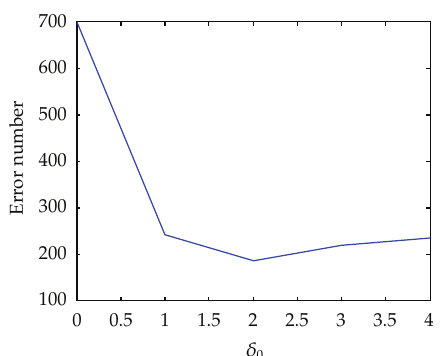
Figure 12: Error number with respect to the parameter δ 0